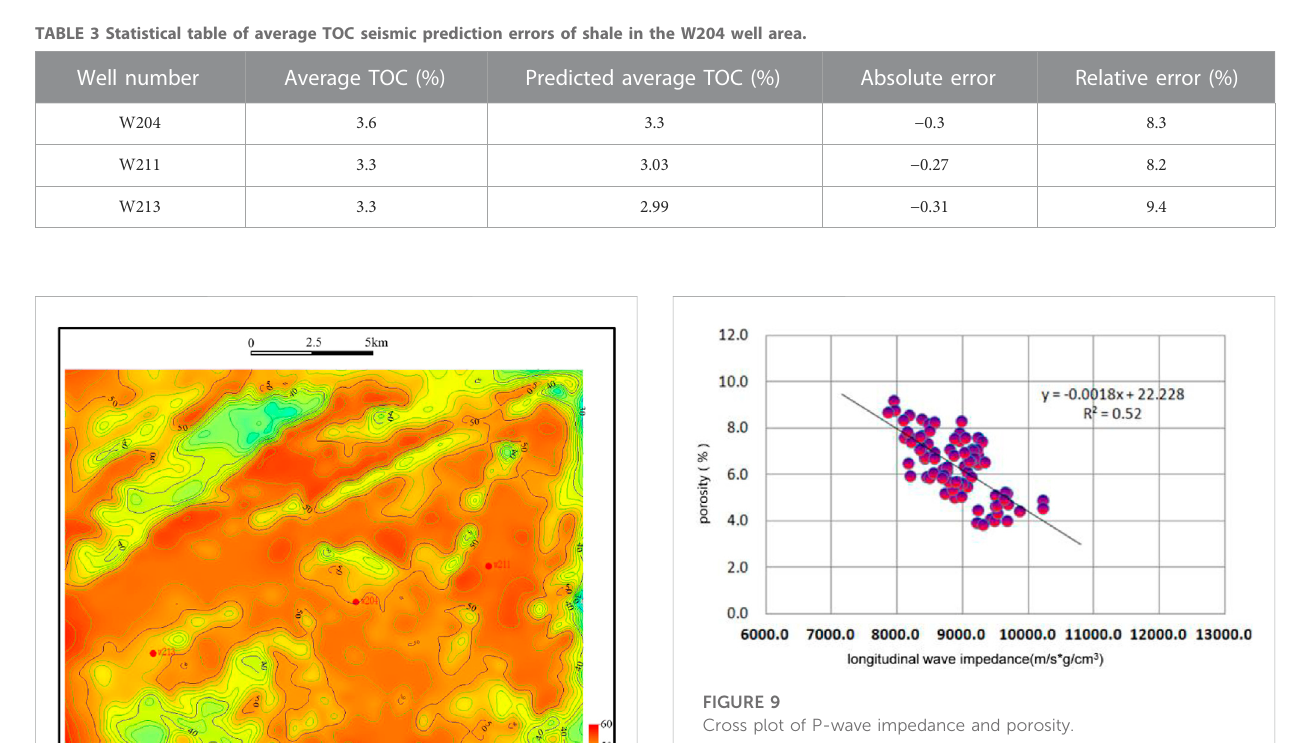
FIGURE 9 Cross plot of P-wave impedance and